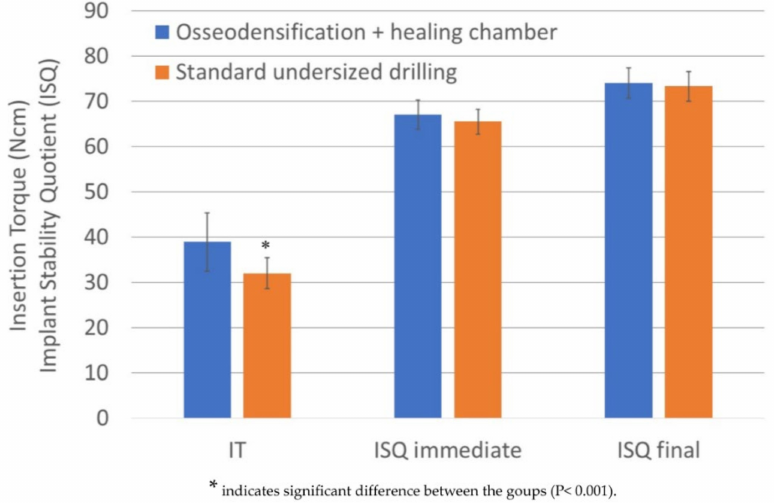
Figure 5. IT (Ncm) and ISQ values of osseodensification + healing chamber and standard undersized drilling